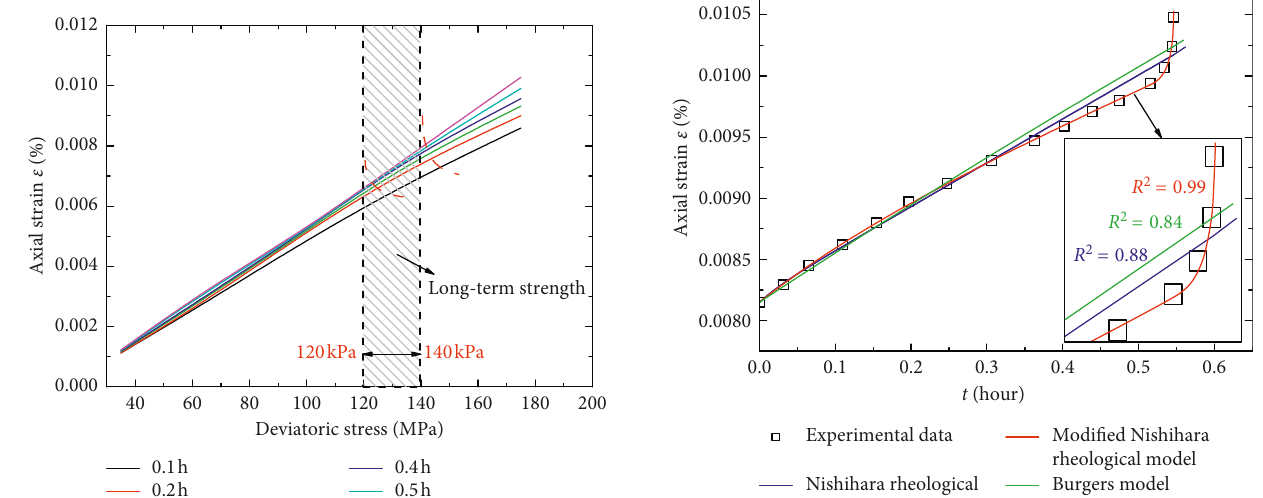
Figure 6: Isochronous curves of sample ( σ